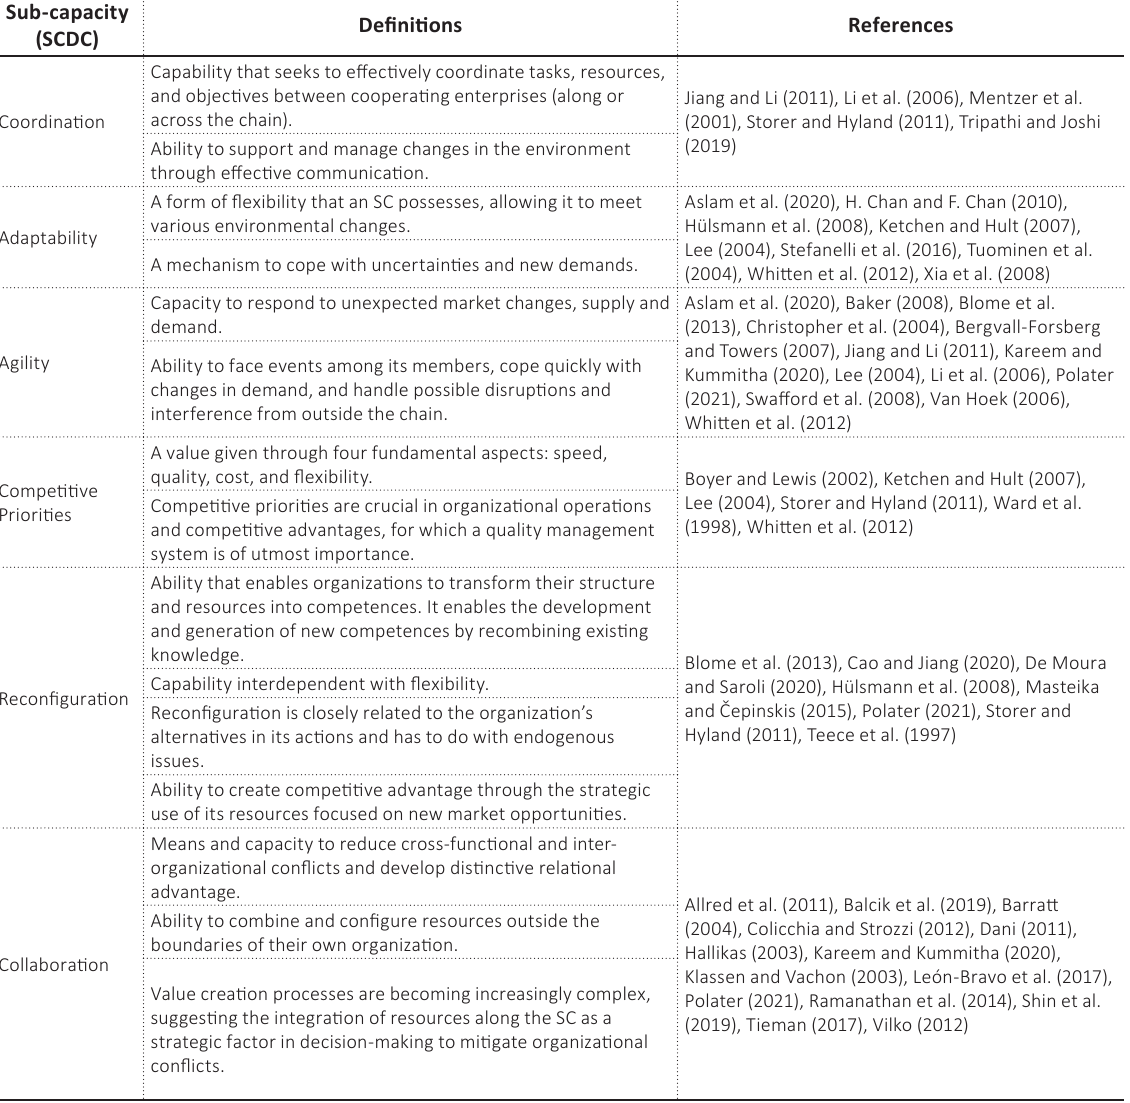
Table 2. Definition of main